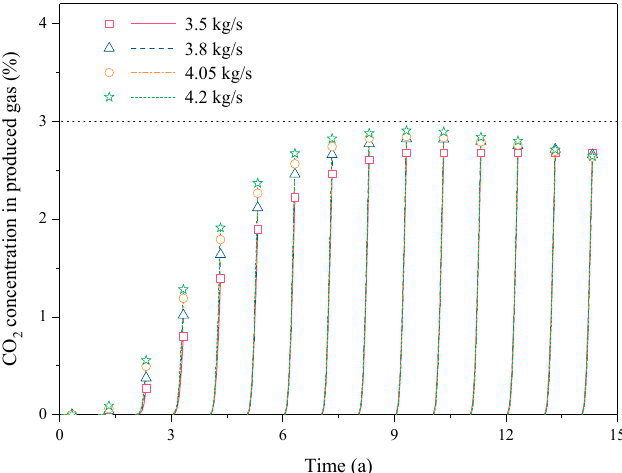
Energies 2020 , 13 , 576 Figure 25. Thickness of the mixed zone for di ff erent for di ff erent production rates. Figure 25. Thickness of the mixed zone for different for different production rates.